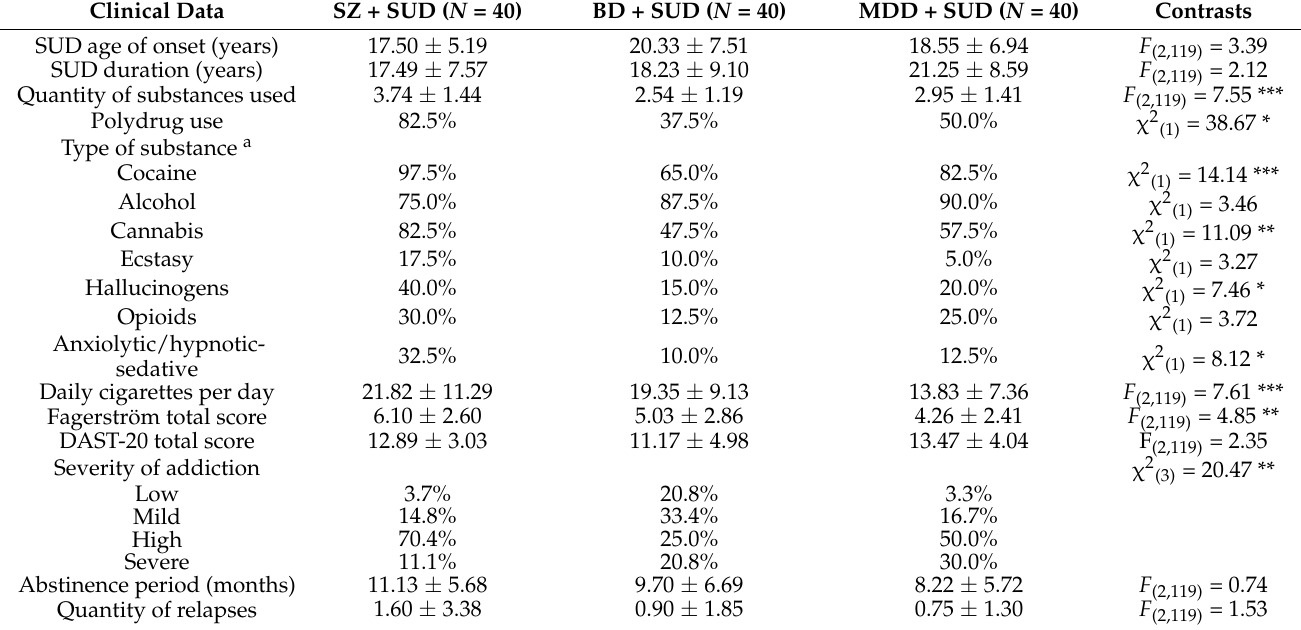
Table 3. Clinical data for the three groups of patients regarding substance use and substance use disorder. Means, standard deviation, percentages and statistical contrasts (ANOVA and chi-square